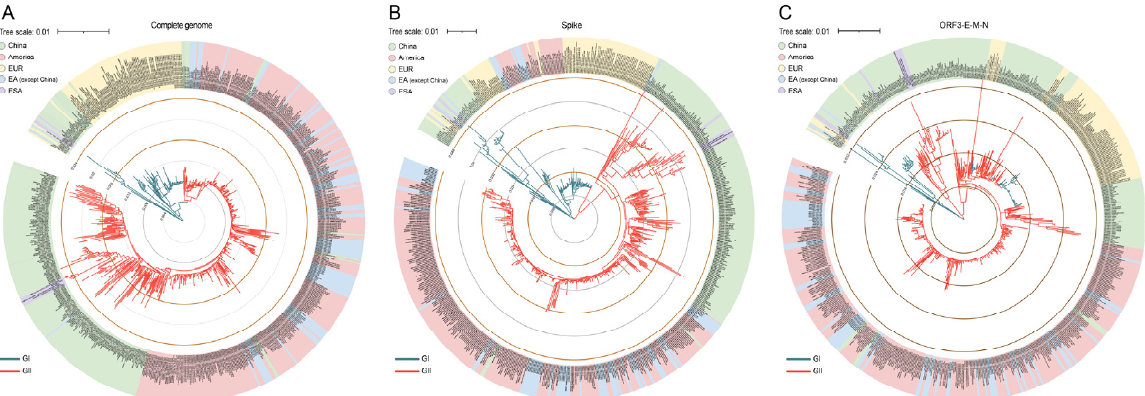
Figure 2. Genotyping and origin of the 647 PEDV strains based on different genes. Phylogenetic trees were constructed by the maximum-likelihood (ML) method based on: ( A ) complete genome, ( B ) S gene, and ( C ) ORF3-E-M-N gene sequences, with 1000 bootstrap replicates. Names of strains, isolation regions (EUR, Europe; EA, Japan and South Korean; ESA, Southeast Asia), GenBank accession numbers and genogroups are shown.